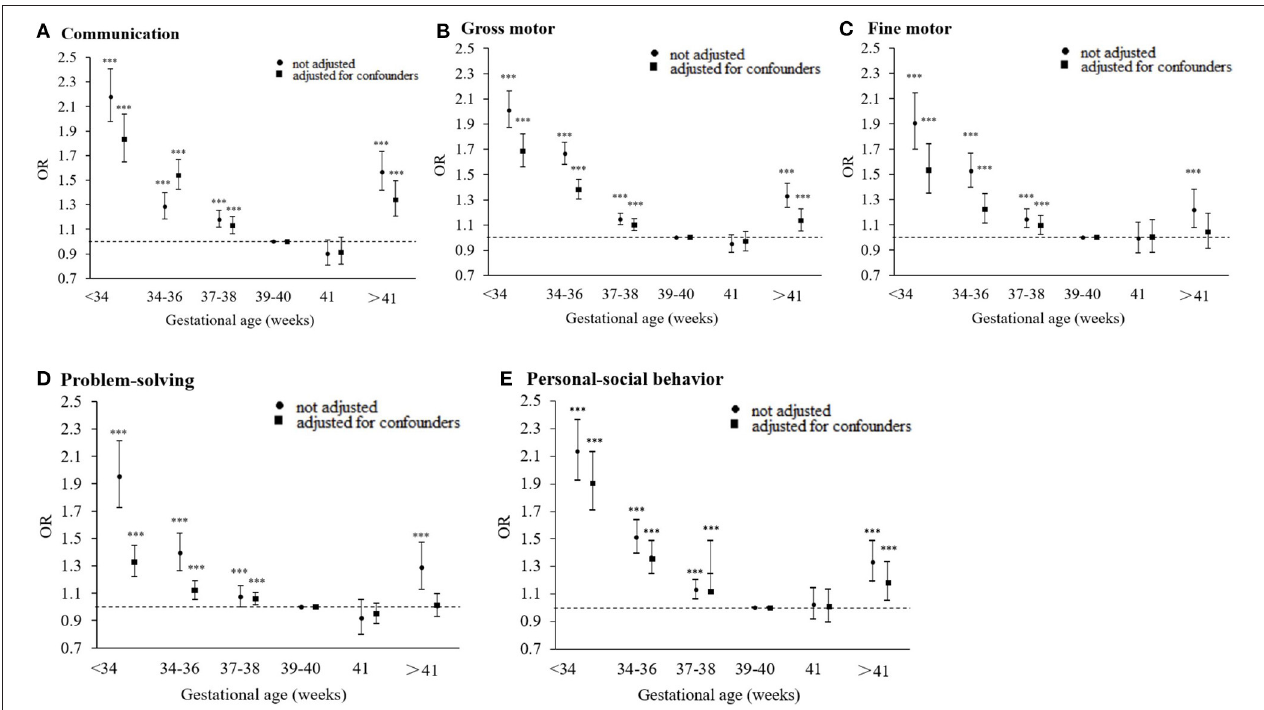
FIGURE 3 | Association between gestational age (weeks) and neurodevelopmental delays in preschoolers when adjusting or not adjusting for child, family characteristics and maternal health during pregnancy ( n = 137 530); (A–E) refers to the different domains (*** p <